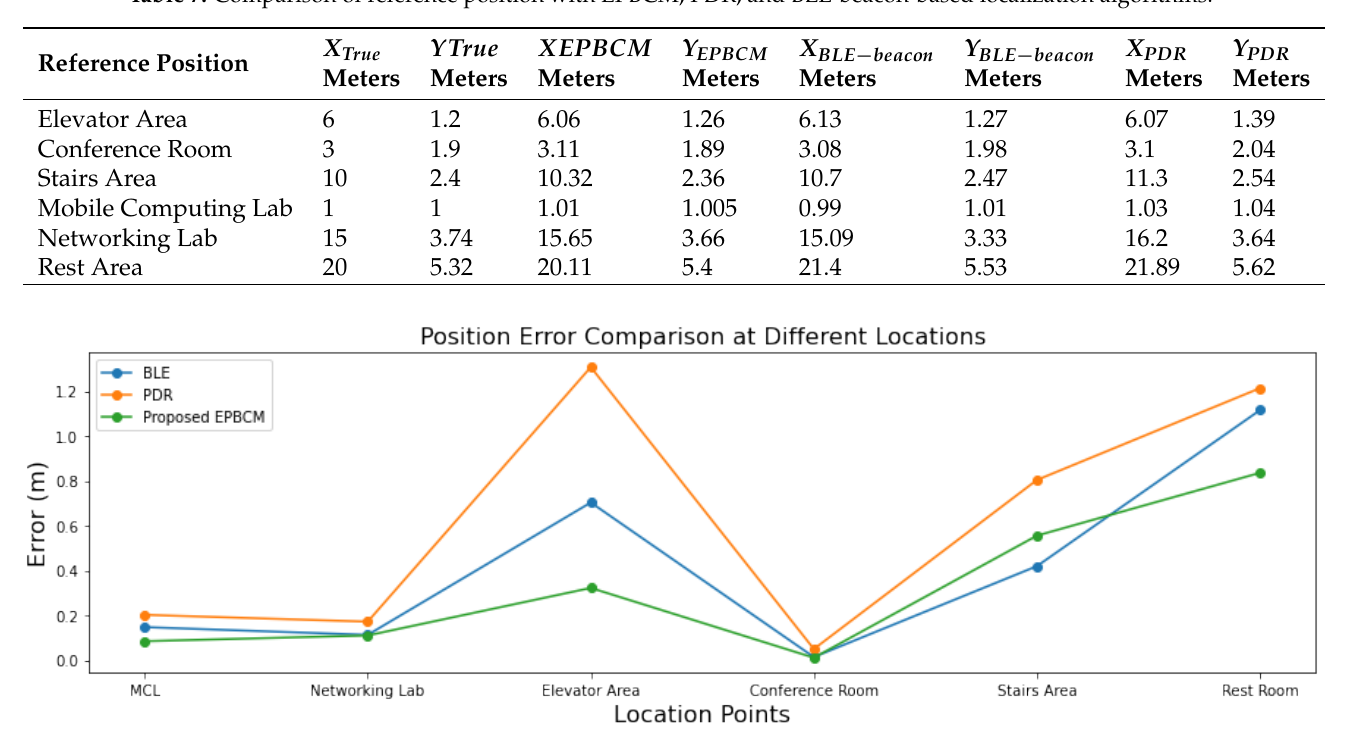
Figure 9. Position Calculation based on EPBCM, PDR, and BLE-beacon at different mobile locations.